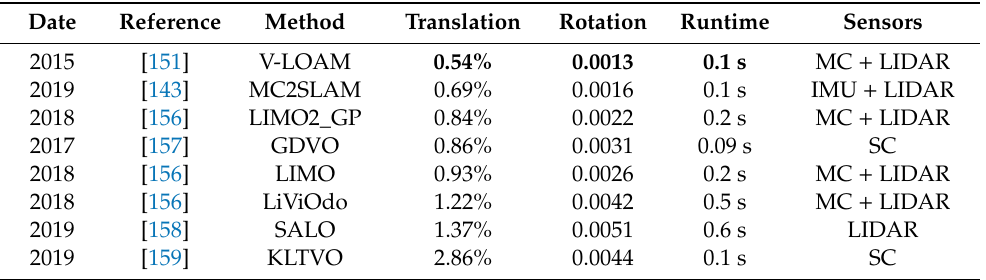
Table 8. Summary of recent VO approaches based on non-deep-learning approaches, as reported on the KITTI website.